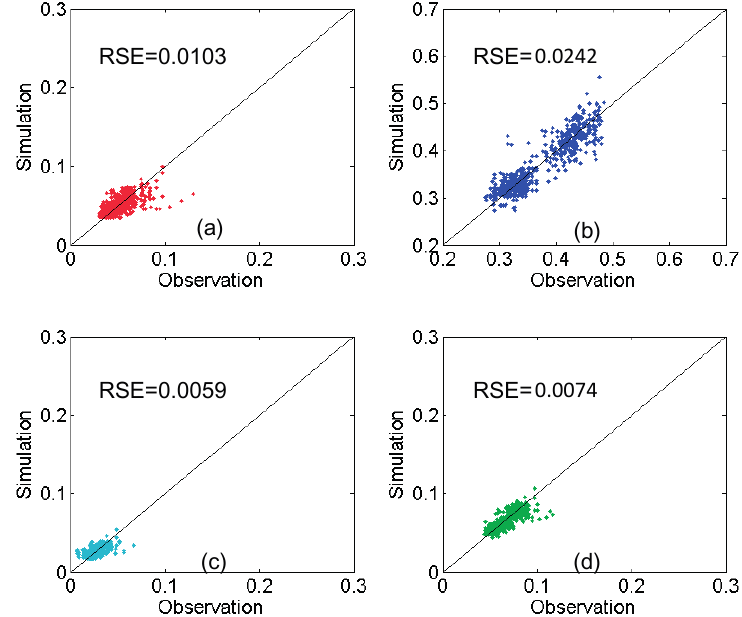
Figure 4. MODIS reflectance comparisons between the simulations and observations: